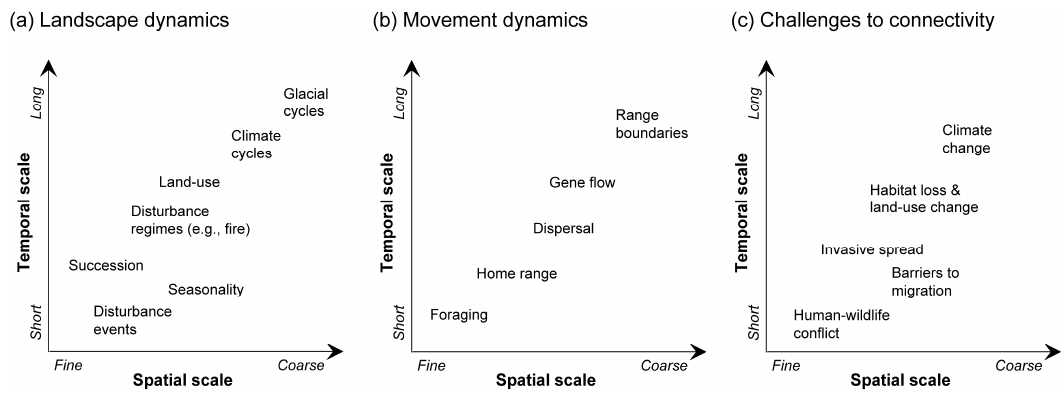
Figure 2. Spatiotemporal scaling issues in dynamic landscape connectivity approaches. ( a ) Landscape dynamics, ( b ) movement dynamics, and ( c ) challenges to connectivity have processes at fine to coarse spatial scales over short to long temporal scales. The interplay of all three of these features drives dynamic landscape